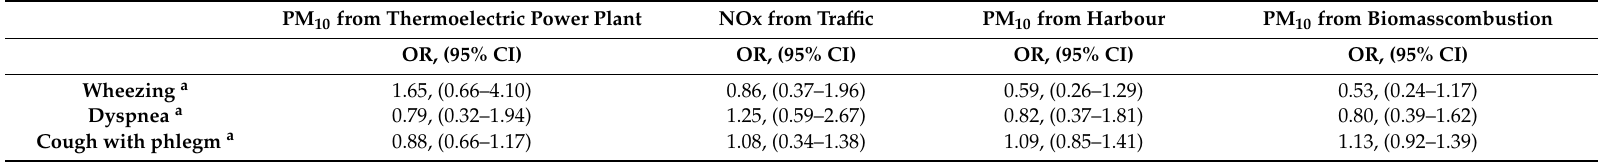
Table 3. Association between PM10 from thermoelectric power plant, from harbour, from biomass combustion, and NOx from tra ffi c and respiratory symptoms. Adjusted odds ratios (ORs and 95% CI).